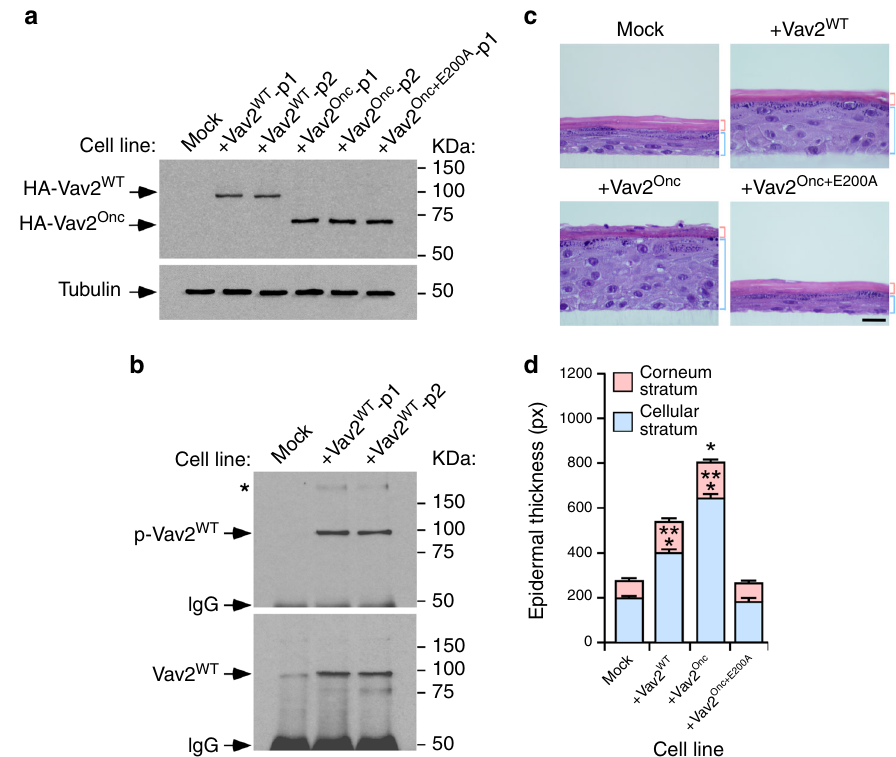
Fig. 8 Wild-type VAV2 also triggers keratinocyte hyperplasia. a Immunoblots showing the expression of the indicated Vav2 proteins in human keratinocytes (top panel). Tubulin was used as loading control in all cases (bottom panel) ( n = 3 independent experiments). p1 and p2 refer to two independent pools of cells. b Tyrosine-phosphorylation levels (top panel) of immunoprecipitated Vav2 WT (bottom panel) in the keratinocyte cell lines. Similar data were obtained in two additional independent experiments. p, tyrosine-phosphorylated. IgG, immunoglobulin band derived from the antibody used in the immunoprecipitation step. The asterisk marks a high molecular weight tyrosine-phosphorylated protein that coimmunoprecipitates with Vav2. c Representative images of hematoxylin/eosin-stained organotypic cultures generated by the indicated cells (top). The thickness of the corneum and cellular epidermal strata is indicated with red and blue brackets, respectively. Scale bar, 10 μ m ( n = 3 independent cultures). d Thickness of the cellular and corneum strata using data from c . * P = 0.013; *** P < 0.0001 (ANOVA and Dunnett ’ s multiple comparison test, n = 3 independent cultures). Data represent the mean ± SEM. Source data for this fi gure are provided as a Source Data fi